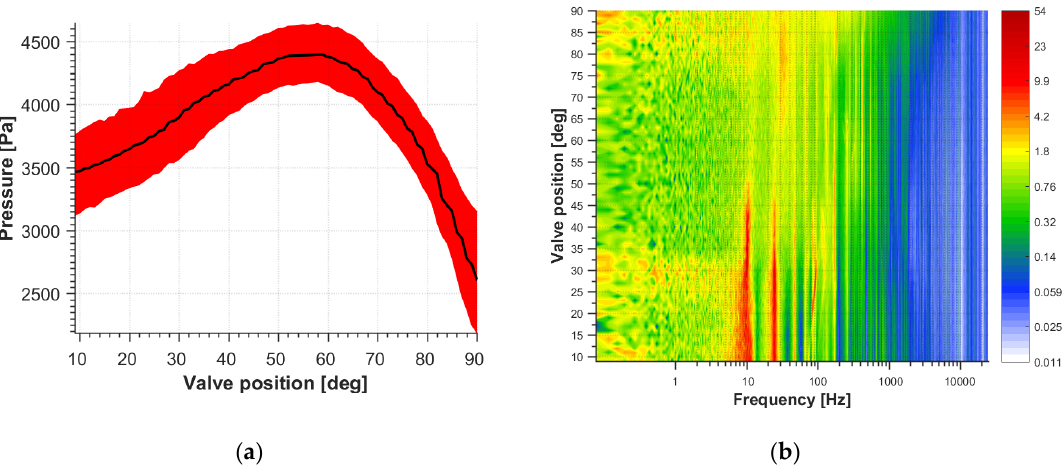
Figure 8. Pressure variation depending on the valve position measured at the outlet at impeller rotational speed 95 Hz. ( a ) The left plot represents the min-to-max plot (red) and the pressure average value (black). ( b ) The right plot represents the spectral map with the colormap in the logarithmic scale.